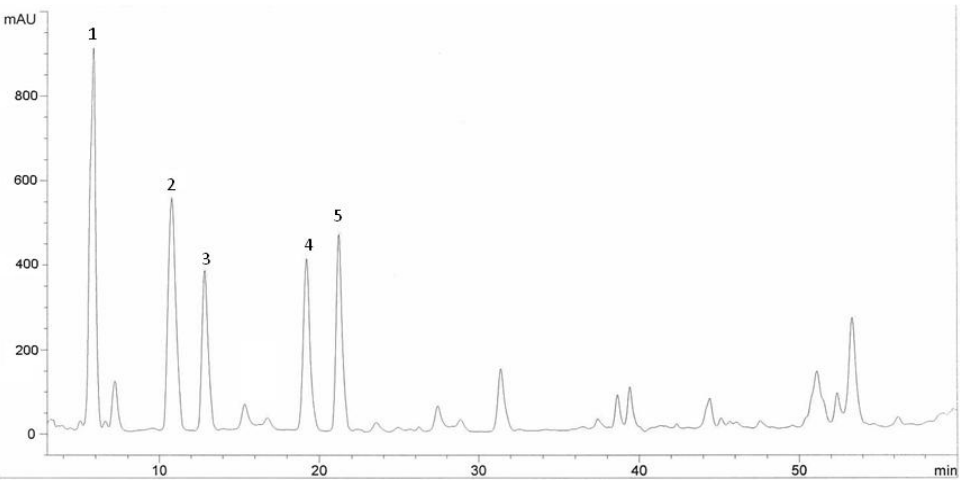
Figure 2. HPLC chromatogram of Halia Bentong ginger ( Zingiber officinale ) leaves extracts. Identification of compounds: gallic acid (1), vanillic acid (2), ferulic acid (3), cinnamic acid (4), salicylic acid (5).